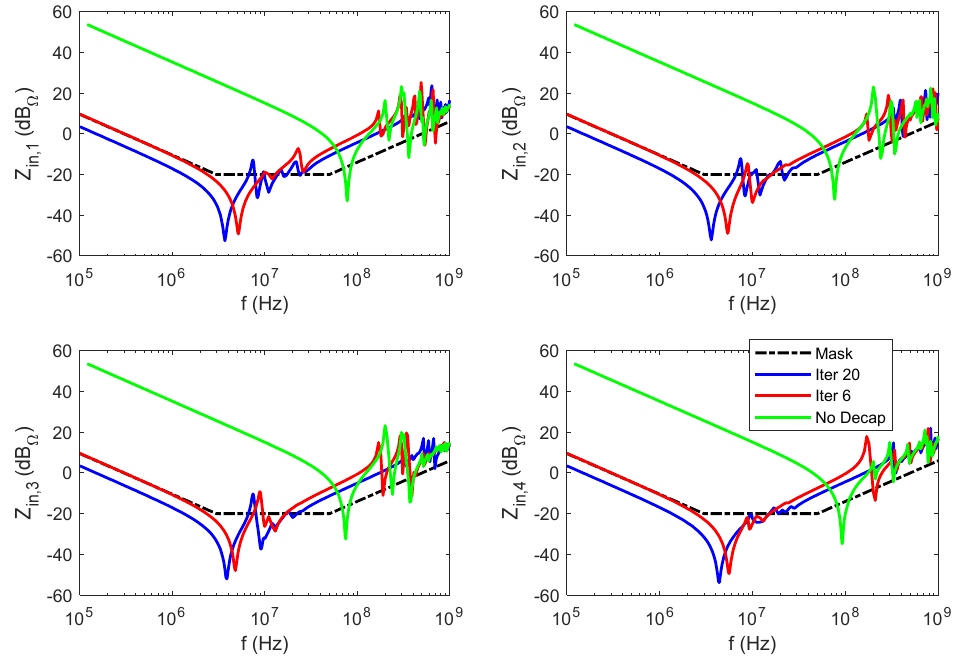
Figure 7. Frequency spectra of the optimized input impedances at the four ports for six and 20 iterations (number of decaps). The input impedances are compared to the case of the PDN with no decaps and to the user-defined mask.